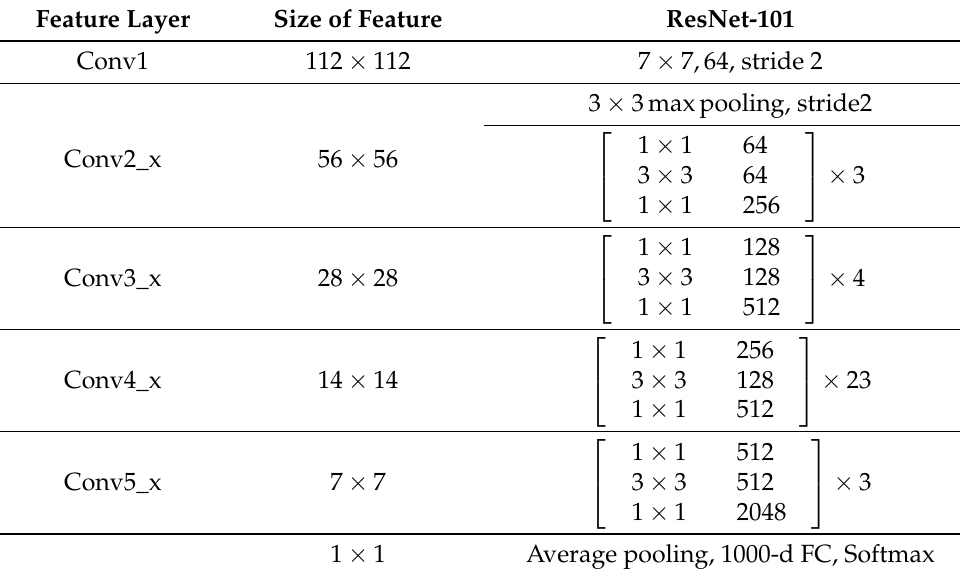
Figure 6. Structure of residual connection. Table 1. Structure of the ResNet-101 network used in this